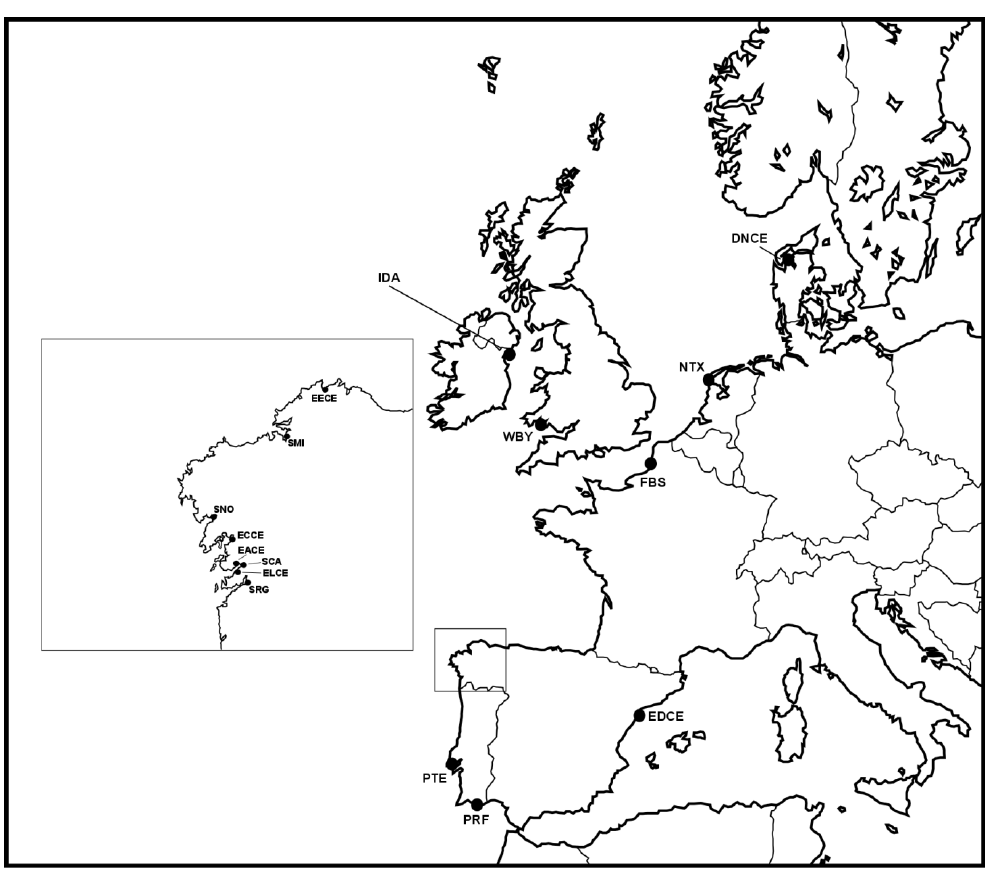
Figure 1. Geographical situation of the natural beds analyzed in the present studies. Codes are shown on Table